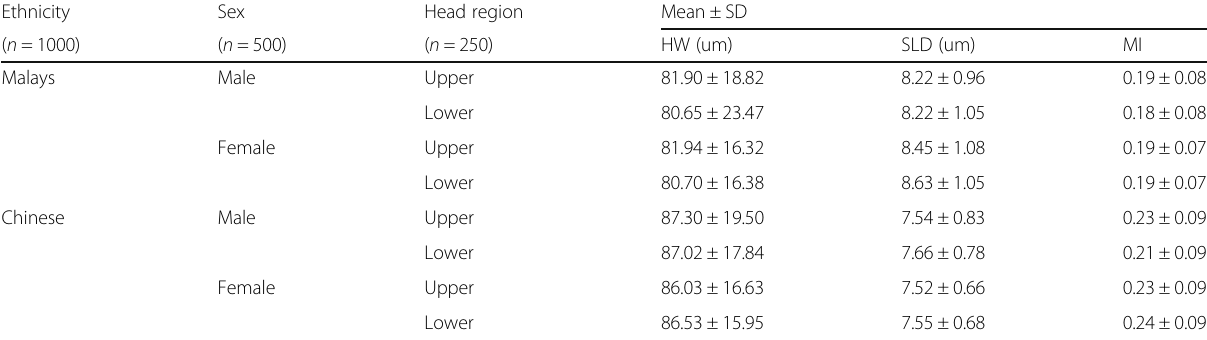
Table 2 Summary statistics of the morphometry of hair by ethnicity, sex, and head regions